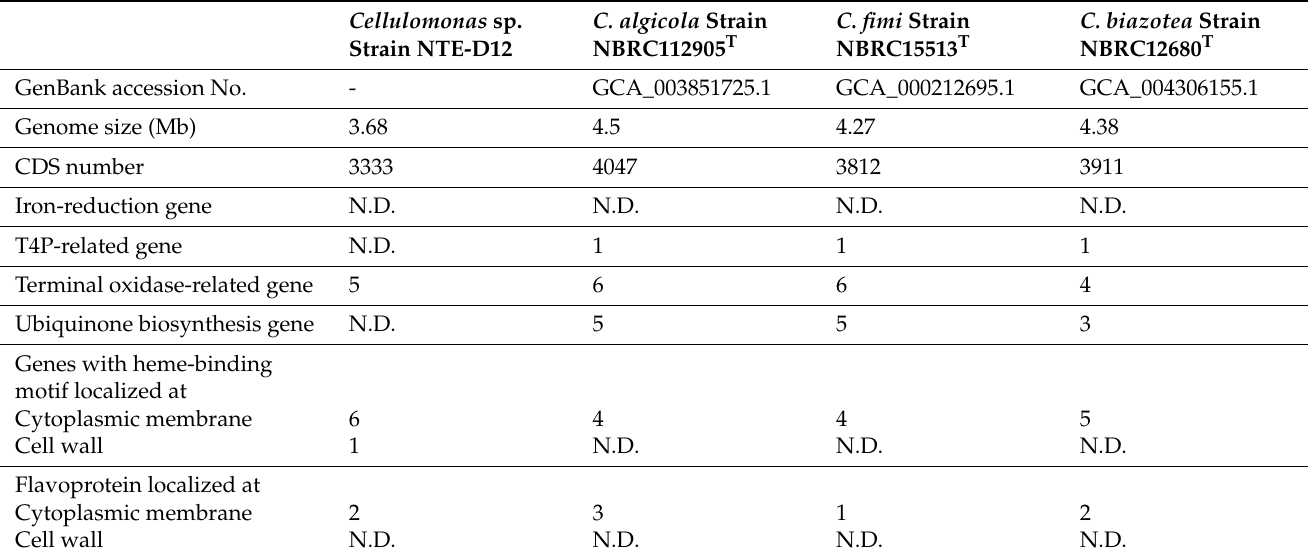
Table 1. Genomic features of Cellulomonas sp. strain NTE-D12 and three related species. Cellulomonas